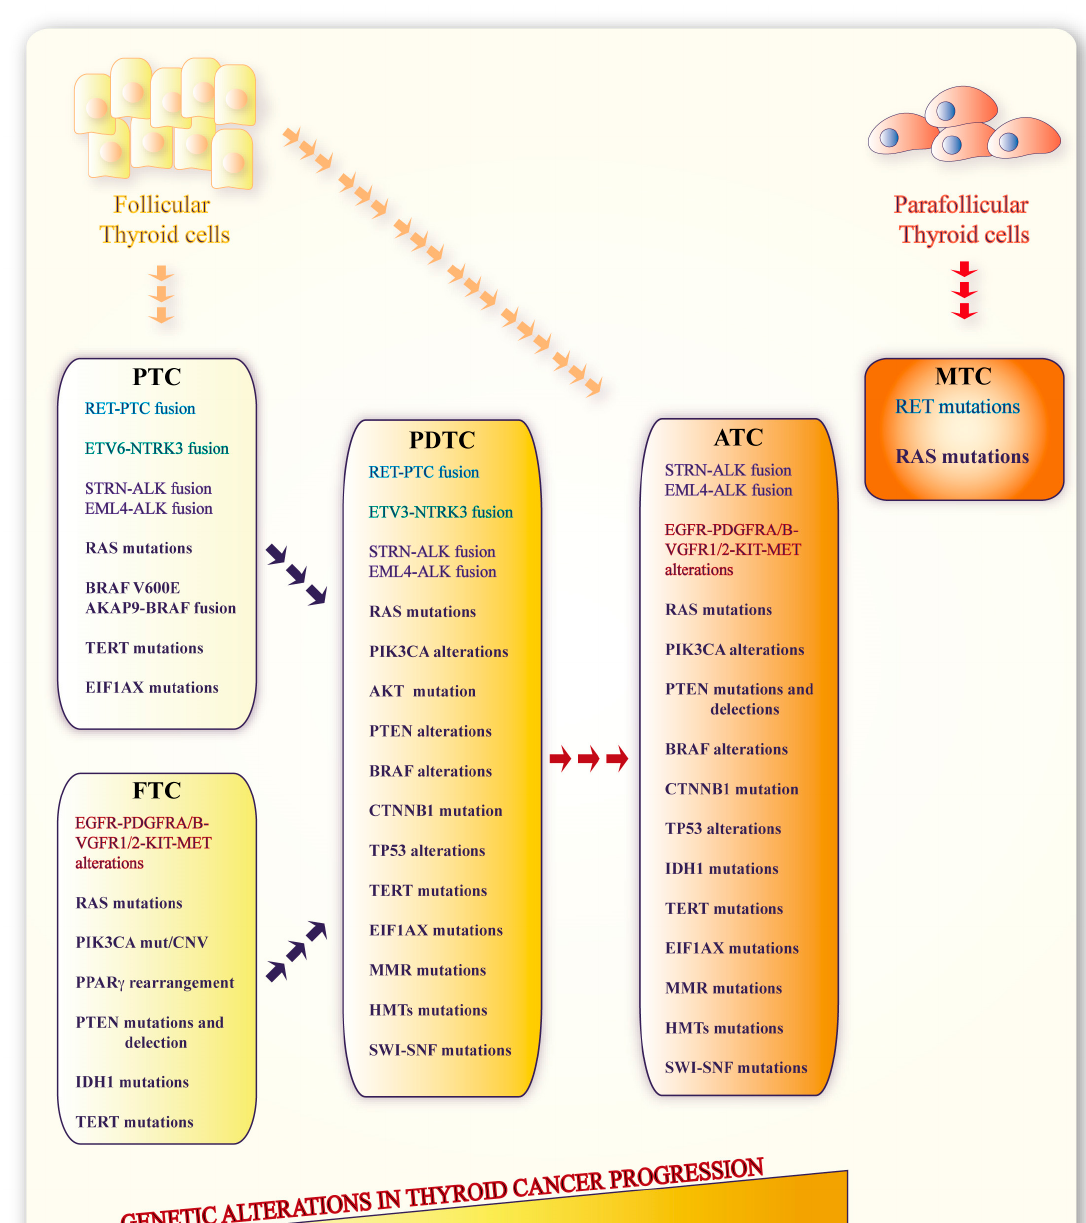
Figure 1. Genetic events involved in thyroid carcinogenesis. Papillary thyroid carcinomas (PTC), follicular thyroid carcinomas (FTC) and anaplastic thyroid carcinomas (ATC) originate from thyroid follicular cells and are characterized by molecular alterations (mutations, deletions, gene fusions) involving genes and proteins impinging upon different cellular pathways. The transition from PTC/FTC to poorly differentiated (PDTCs) and ATCs is attributed to additional molecular alterations. Medullary thyroid carcinoma (MTC) originates from para-follicular C-cells and is prevalently characterized by RET or RAS mutations.